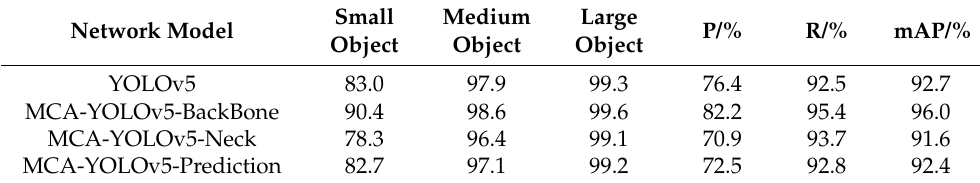
Figure 7. The YOLOv5s model of the three fused MCA modules (This is a visual representation of the MCA module placed in three different positions on the YOLOV5 model. ( a ) put the MCA module in the backbone network; ( b ) means put the MCA in the neck network and the MCA in ( c ) is in the prediction part). Table 2. Comparison of the MCA module fusion results (The results of large, medium and small object detection when the MCA module located at backbone network, neck and prediction parts in the